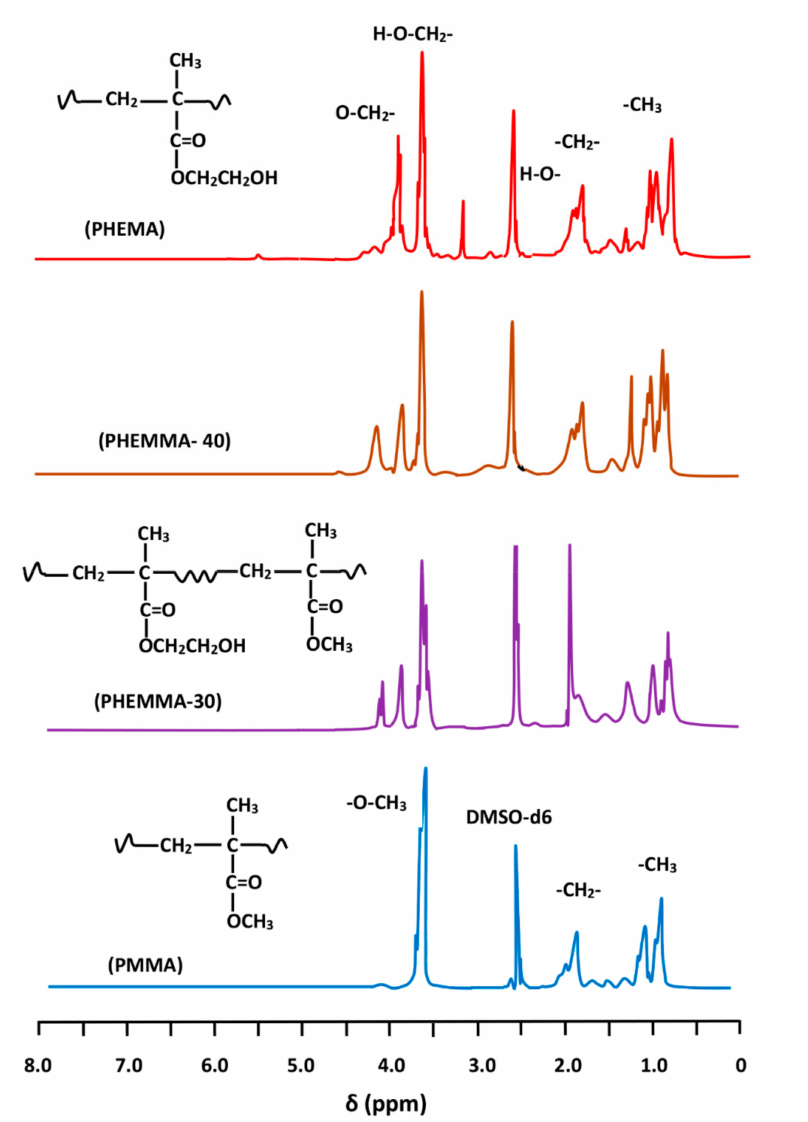
Figure 1. 1 H-NMR spectra of PHEMA, PMMA homopolymers, and PHEMMA copolymers with di ff erent